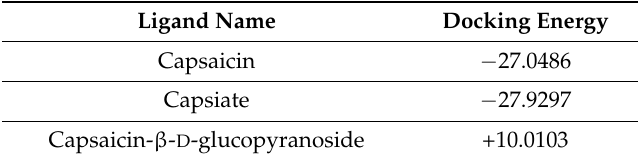
Table 2. Docking energies for CAP, Capsiate, and CAP- β - D